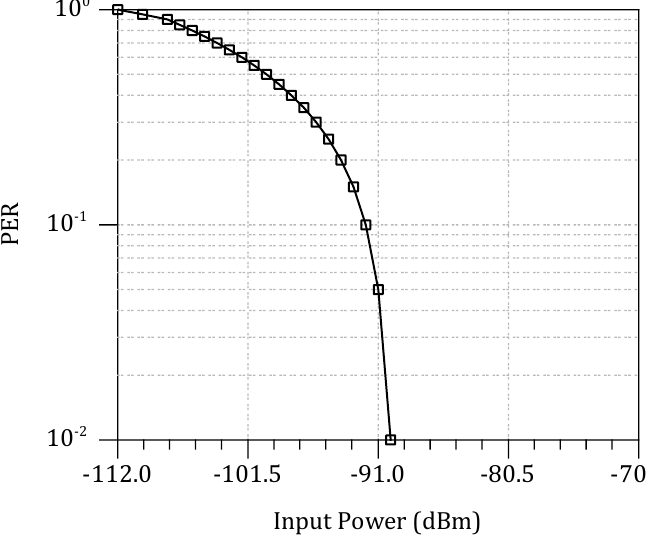
Figure 19. Packet error rate against the WuRx’s input power.